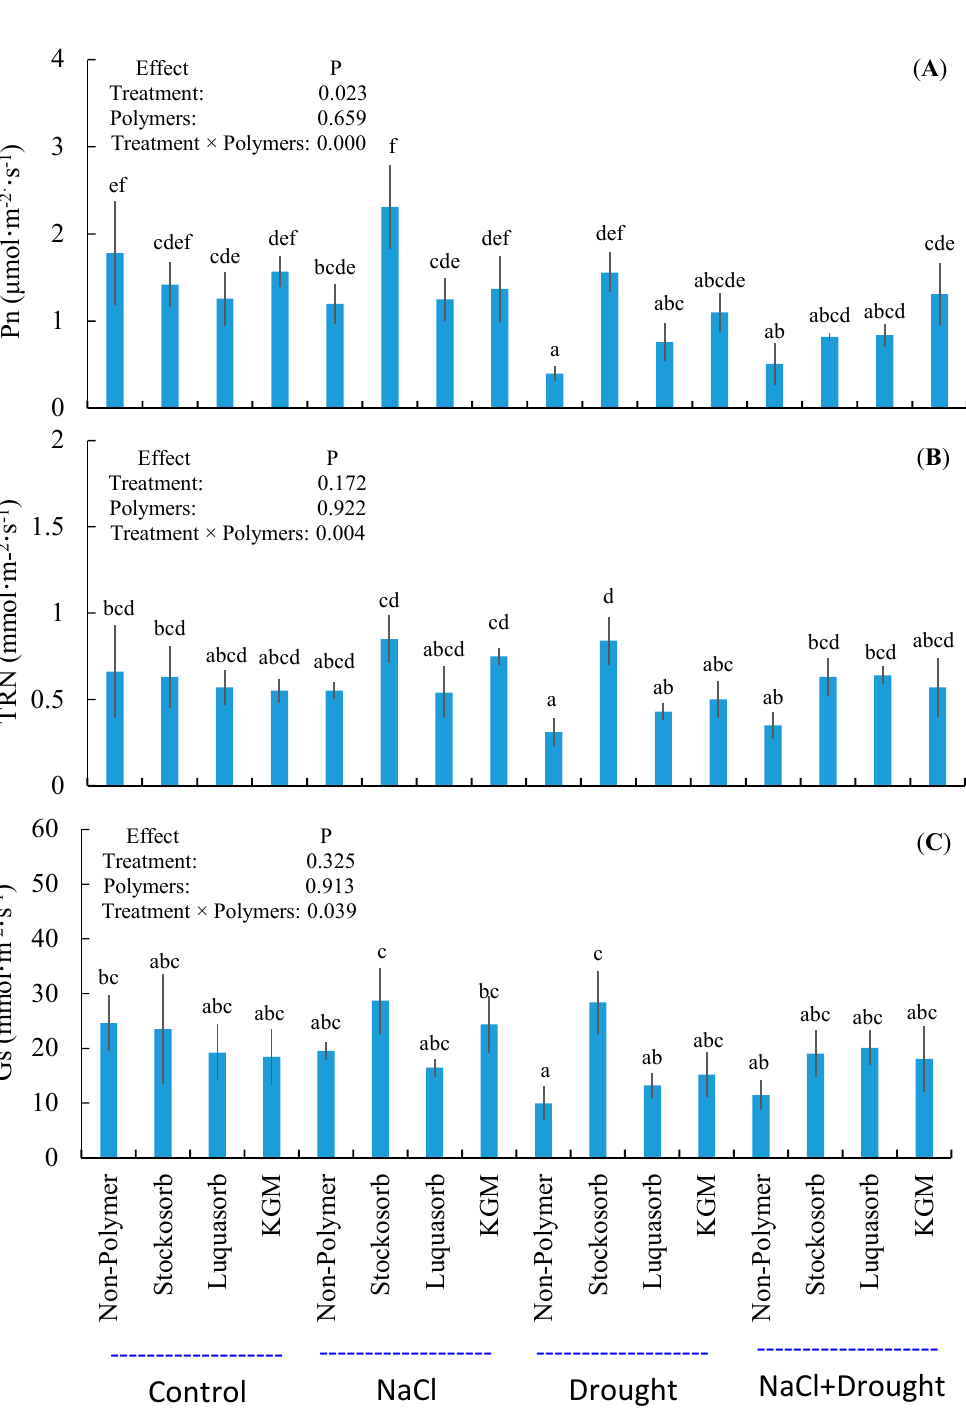
Figure 5. Effect of drought and salt stress on leaf net photosynthetic rates (Pn), transpiration rates (TRN), and stomatal conductance (Gs) in Metasequoia glyptostroboides seedlings amended with synthetic (Stockosorb, Luquasorb) and natural (Konjac glucomannan, KGM) hydrophilic polymers along with those not amended with polymers (Non-Polymer). ( A ): Net photosynthetic rate. ( B ): Transpiration rate. ( C ): Stomatal conductance. Mean gas exchange values were measured on a weekly basis. Each column represents mean values for three to five individual plants and bars represent the standard error of the mean. Columns labelled with different letters (a–f) are significantly different at the p < 0.05 level.